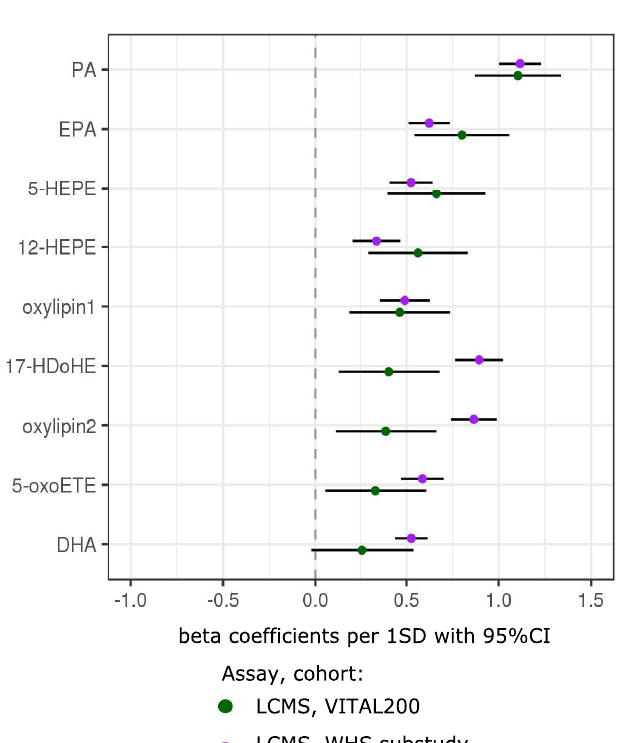
Figure 5. Validation in an independent cohort (the Women’s Health Study (WHS)) of significant (FDR < 0.05) associations between one-year changes in FAs, oxylipins and bioactive lipids with n-3 treatment in VITAL200. Associations between baseline levels with baseline nutritional n-3 intake in the WHS were used for validation. Only compounds with putative annotation using the LCMS assay are presented (LCMS assay — high-throughput liquid chromatography – mass spectrometry of circulating free FAs, oxylipins and bioactive lipids in plasma). Symbols with error bars are beta coefficients per 1SD with 95% confidence intervals. In VITAL200, longitudinal associations are modeled in one-way ANOVA with treatment group assignment as a predictor variable (sex and age were not significant and removed from the model). In the WHS, cross-sectional associations in linear regression were adjusted for age, sex and cardiovascular risk factors (high-density lipoprotein cholesterol (HDLC), total cholesterol, systolic blood pressure, treatment for hypertension, diabetes, current smoking). LCMS bioactive lipid features in VITAL200 were log transformed and their one-year changes were shifted to median 0 and standard deviation (SD) 1. In the WHS, batch effect-corrected baseline levels were log transformed and shifted and rescaled to median 0, SD1.